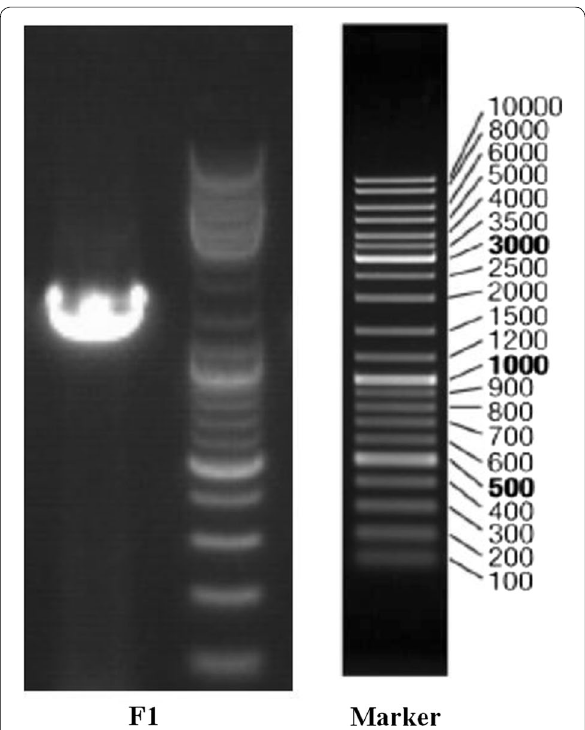
Fig. 1 Amplification of 16S rDNA gene of strain F1 by